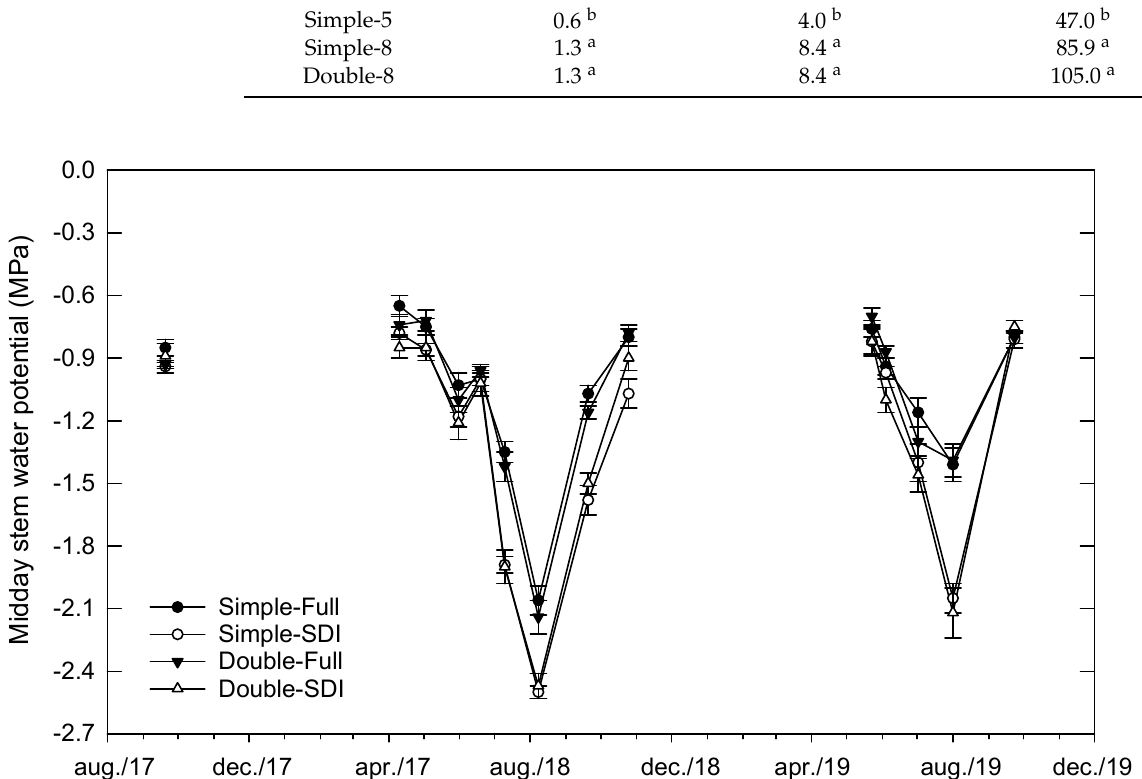
Figure 1. Seasonal variation for midday stem water potential in the different irrigation treatments in the lemon trial. Error bars are the standard error.